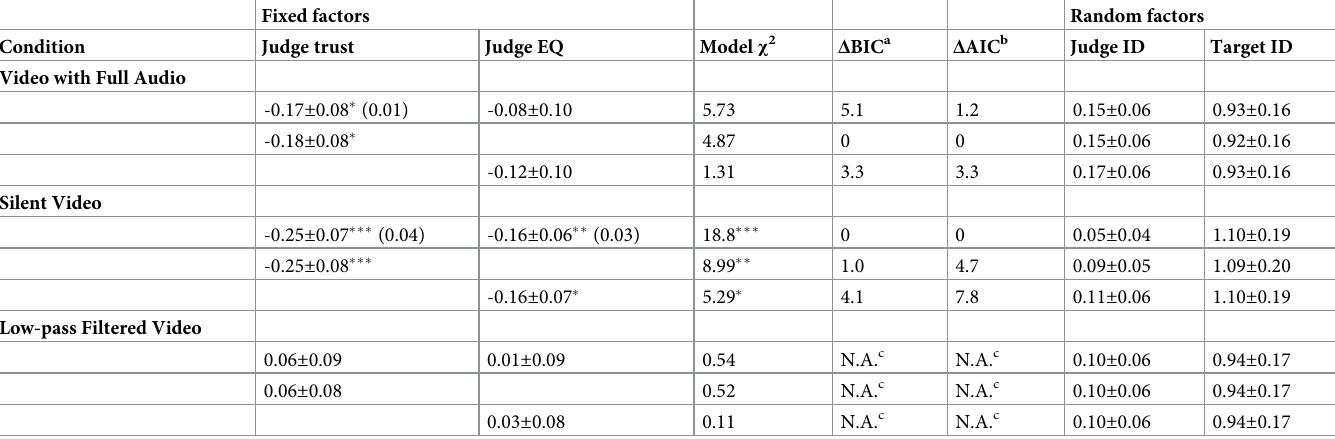
Table 12. Multilevel mixed regression models predicting LORP-LSRP standard difference score for total